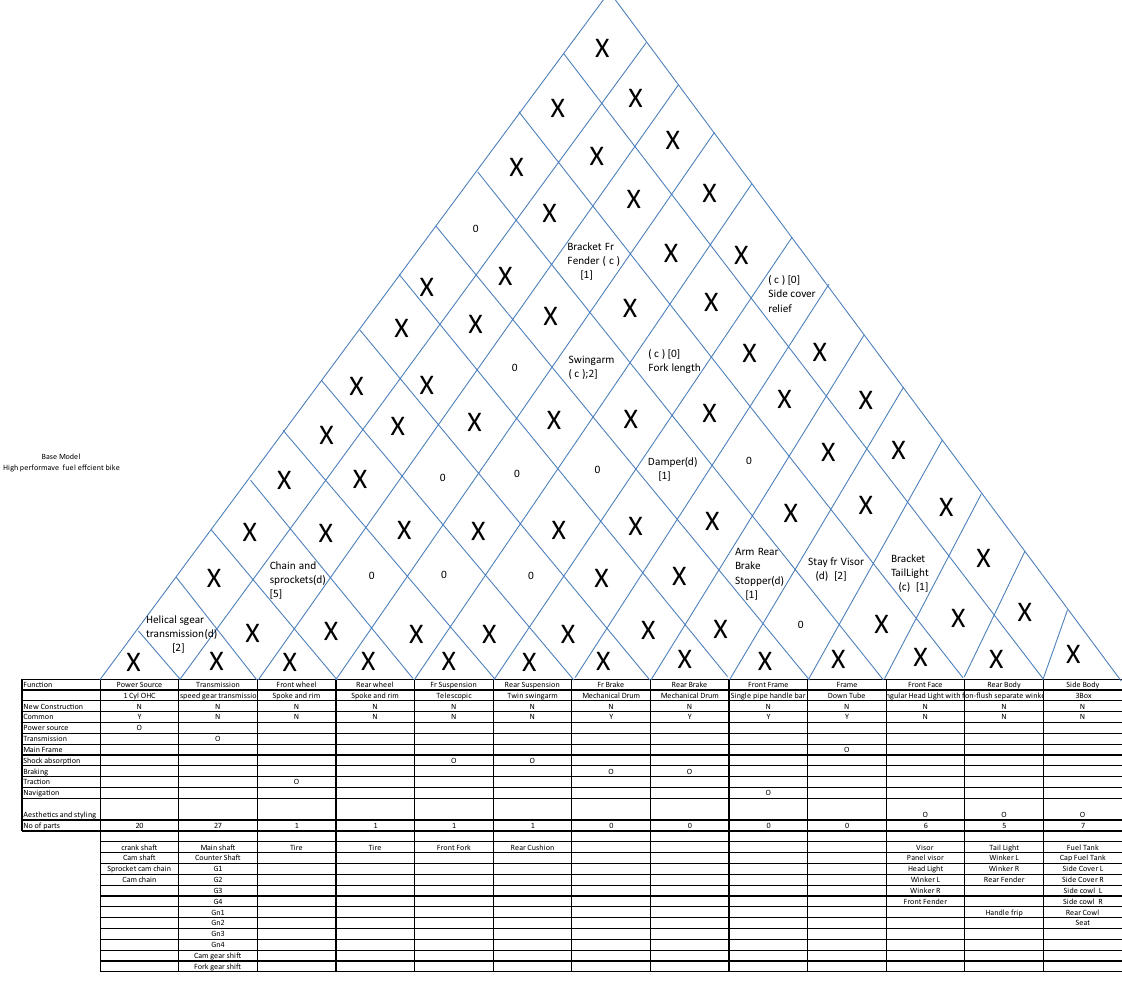
Table 9. System-level architecture for stylish high-performance